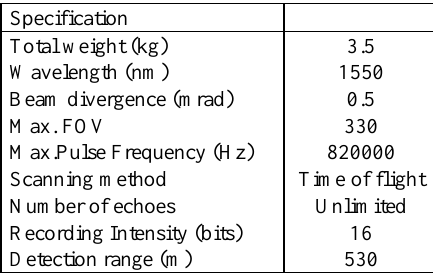
Table 1. Specifications of Riegl VUX-1 lidar system